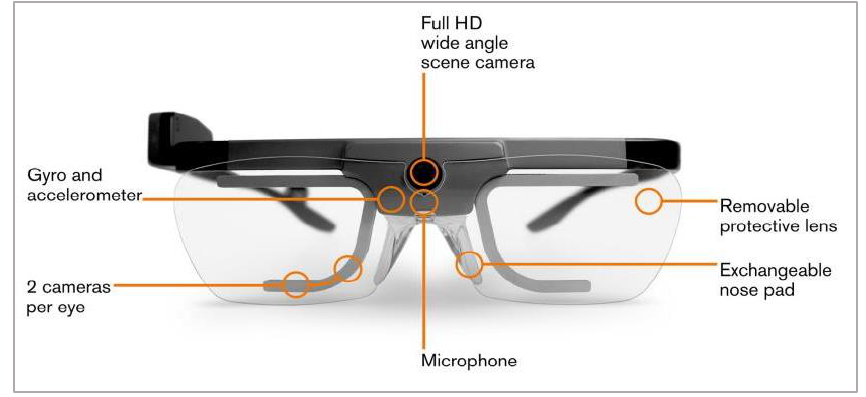
5 of 17 Figure 2. Illustration of the motion platform design with six degrees of freedom of the used simula- tor: ( a ) illustrates the hardware components of the platform; ( b ) illustrates the size of the platform; ( c ) illustrates the pitch, roll, yaw axes enabling 6-DOF motion of the platform. 2.2.2. Eye Tracker To observe visual behavior in our experiment, we used the Tobii 2 50 Hz wireless eye tracker equipped with four eye tracking cameras monitoring the participants’ eyes and one FullHD camera monitoring the environment in front of the participants, as illustrated